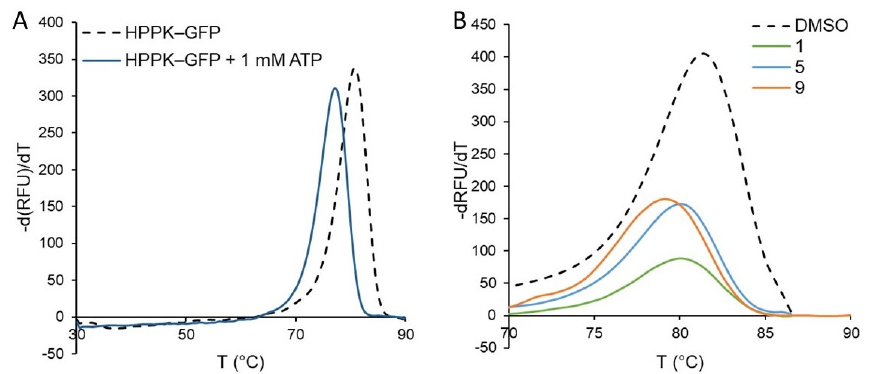
Figure 3. Typical melting temperature curves obtained by DSF-GTP for Pf HPPK-GFP in the presence of 1 mM ATP ( A ) and representative test compounds ( B ).